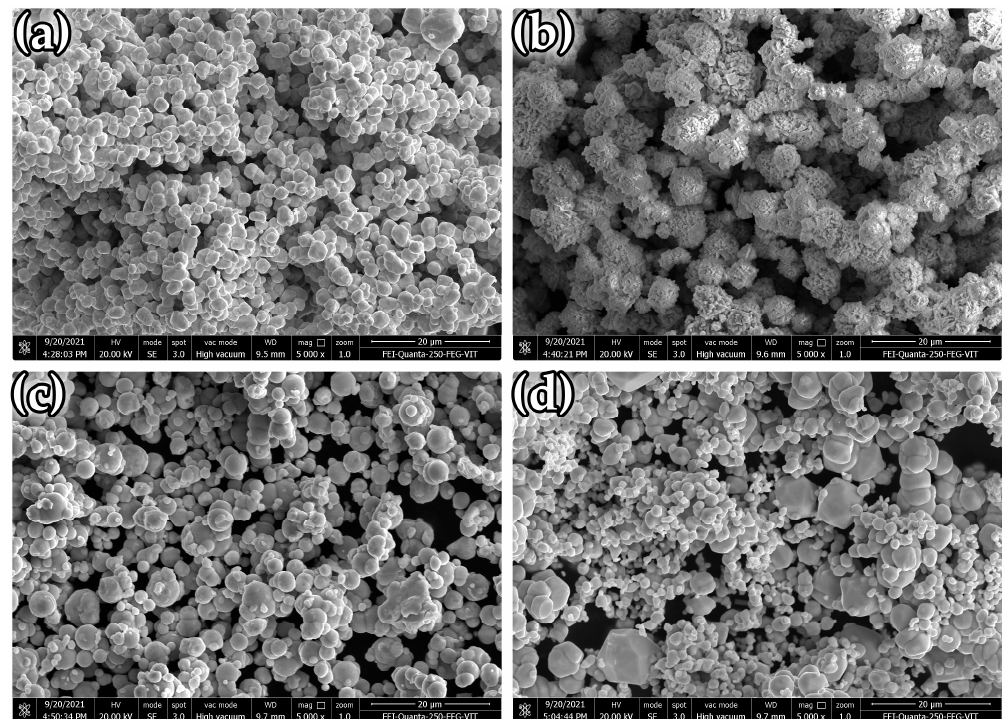
Table 2. Compositions of samples and experimental parameters.